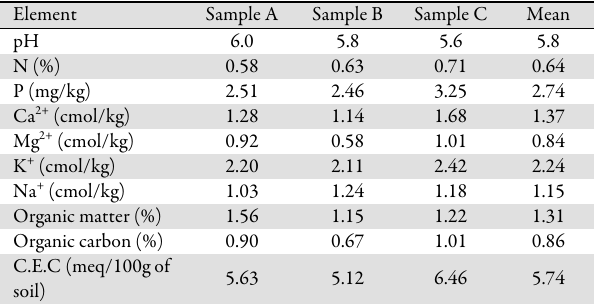
Table 1. Physico-chemical properties of experimental soil Element